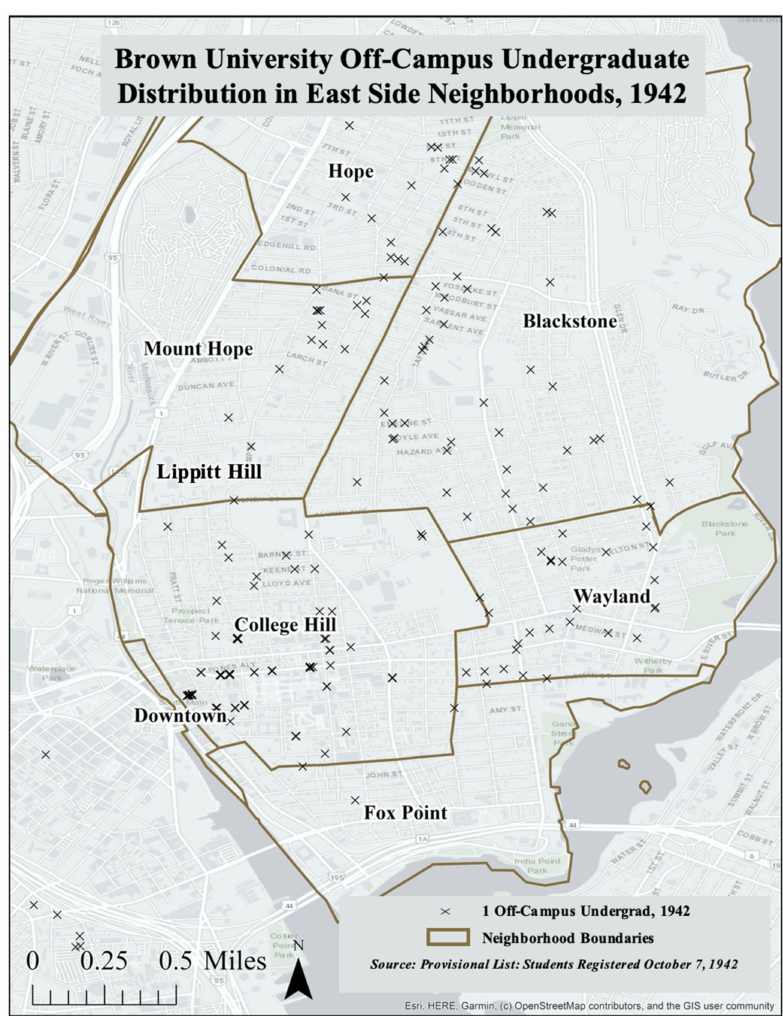
Figure 2. Brown University o ff -campus undergraduate distribution in East Side neighborhoods,